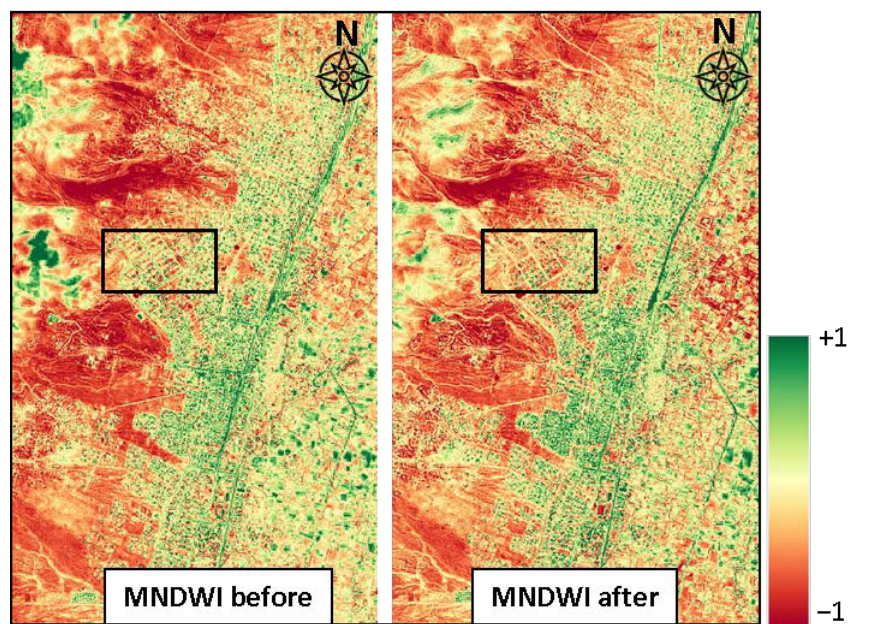
Figure 7. Observation of changes in the study area using pre- and post-event MNDWIs.